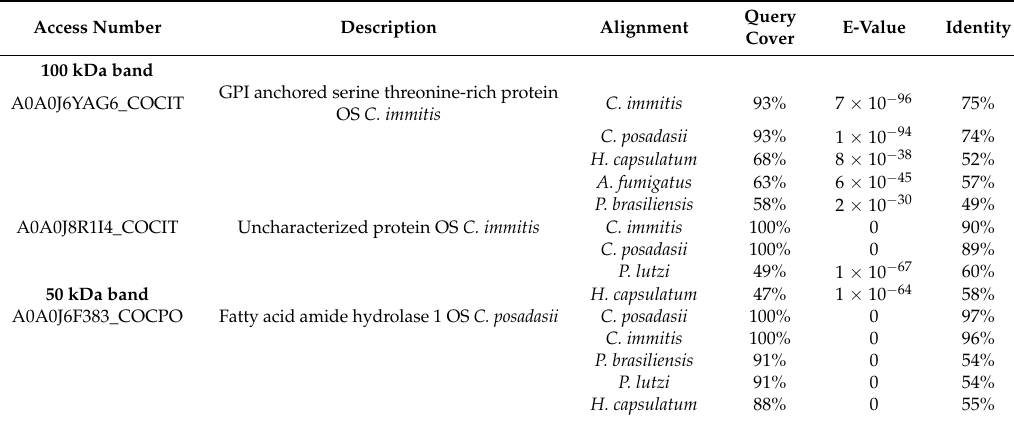
Table 3. Identification of proteins that recognize Coccidioides